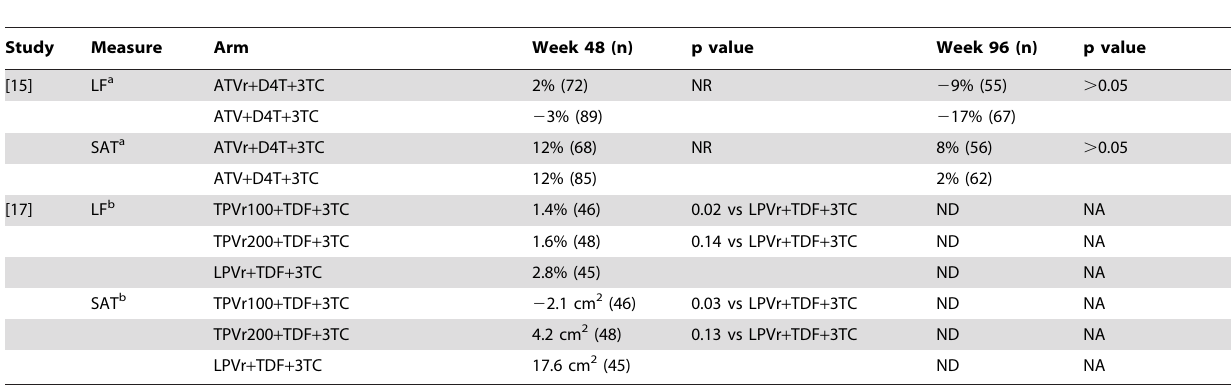
Table 5. Change from baseline in limb fat (LF) on DEXA scan and subcutaneous adipose tissue (SAT) on CT scan: PI versus PI.